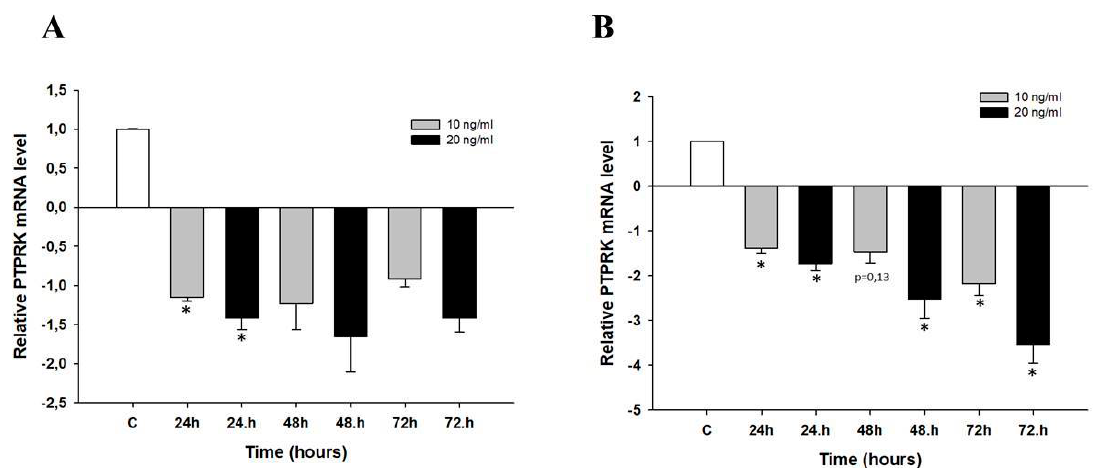
Figure 4. Expression analysis of PTPRK gene in W1 cell line ( A ) and A2780 cell line ( B ) after short time exposure to TOP treatment. The figure presents relative genes expression in TOP treated cells (grey and black bars) with respect to the untreated control (white bars) assigned as 1. The values were considered significant at * p < 0.05.